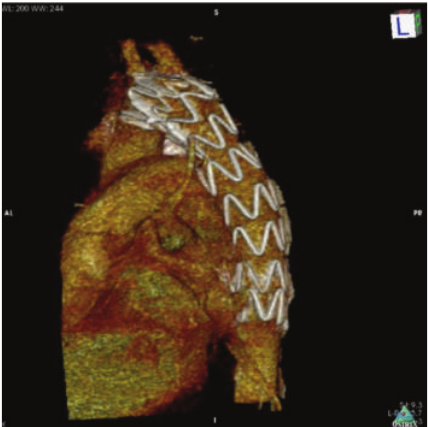
Figure 3: Aortography at postductal segment of descending aorta. Arrow indicates coarcted segment of aorta.